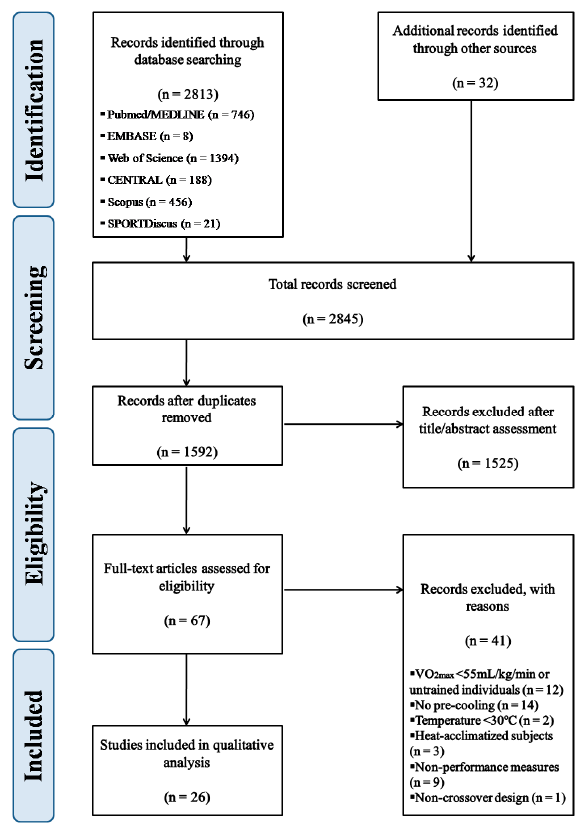
Figure 1. Flow diagram of study selection process.